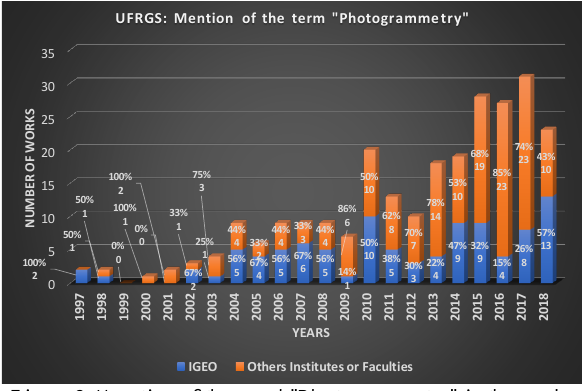
Figure 2. Mention of the word "Photogrammetry" in the works developed at